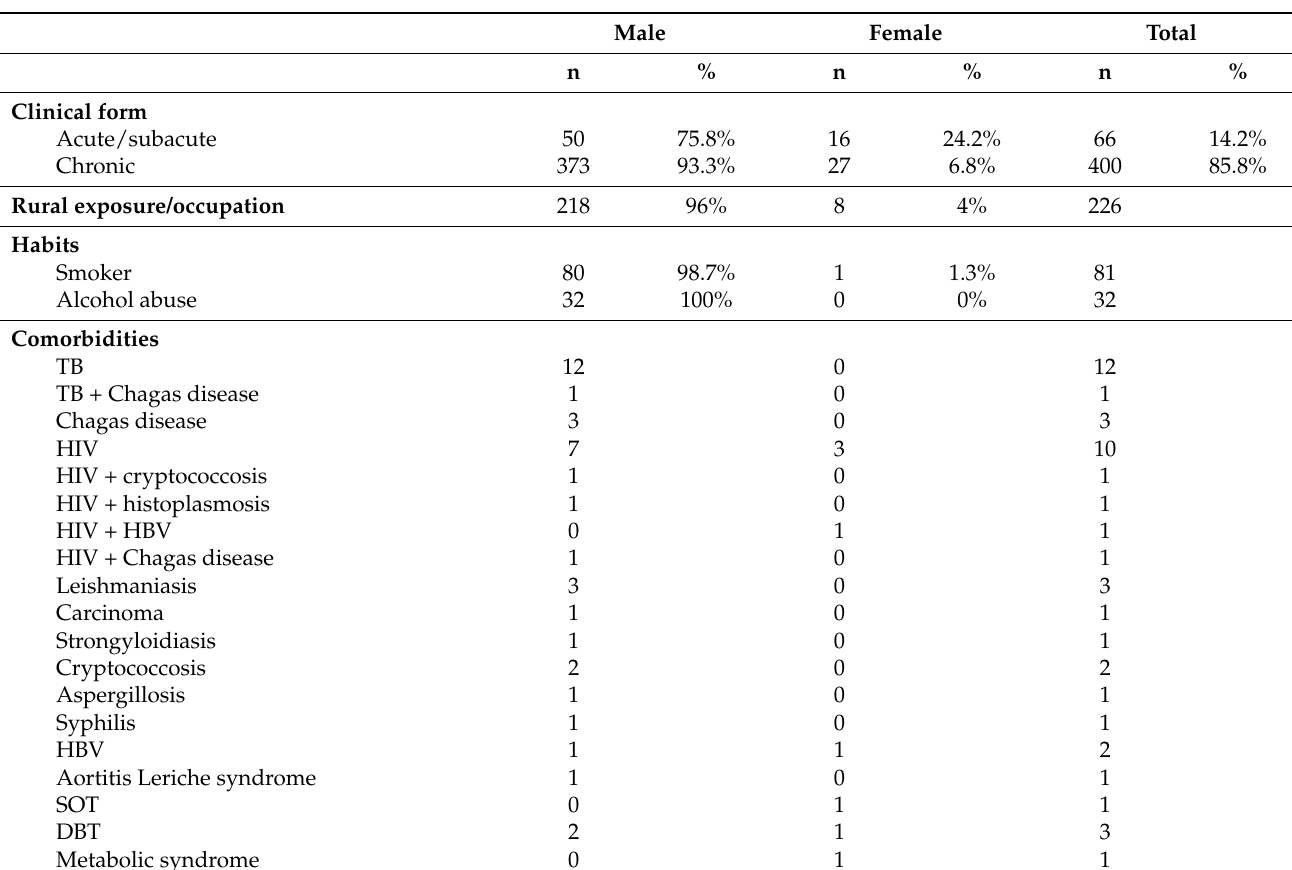
Table 2. Sex distribution analysis considering clinical form, exposure/habits, and comorbidities of 466 clinical cases recorded.